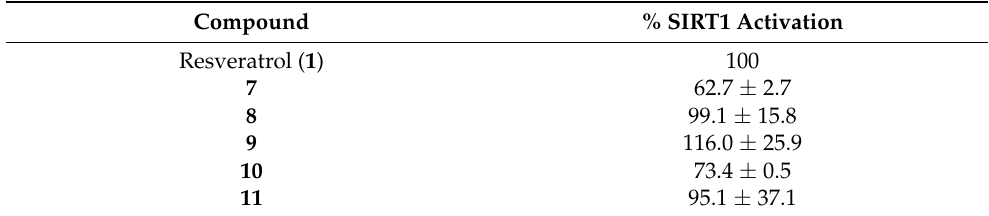
Table 1. Percentage of SIRT1 activation of thiazoles 8–11 compared with that of resveratrol ( 1 ) and compound 7